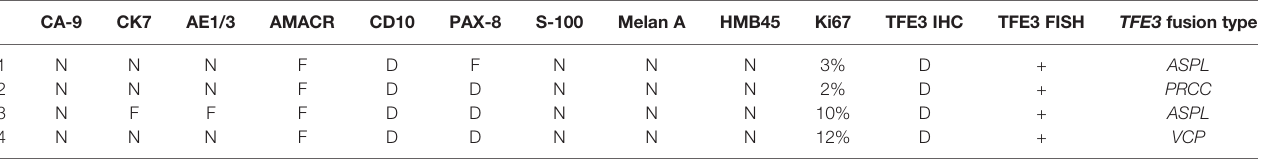
TABLE 2 | Immunohistochemistry, fl uorescence in situ hybridization (FISH), and fusion type pro fi les of four cases of Xp11.2 renal cell carcinoma.